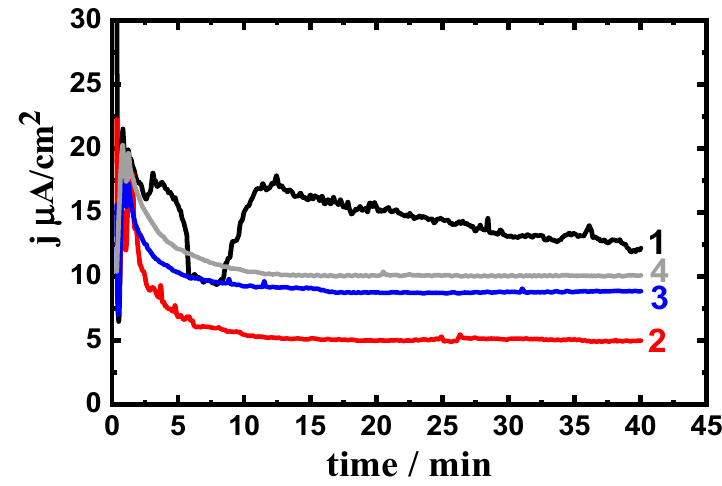
Figure 8. Current–time curves collected at 0.30 V (Ag / AgCl) for (1) Ti6Al2V, (2) Ti6Al4V, (3) Ti6Al6V, and (4) Ti6Al8V alloys after 1 h immersion in 3.5% NaCl solution, respectively.